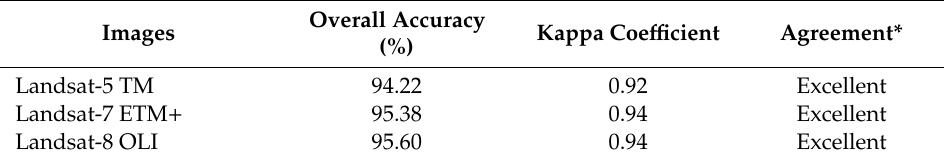
Table 5. Accuracy assessment after pixel trajectory